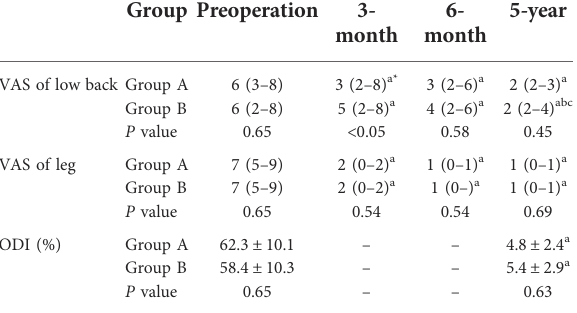
TABLE 3 VAS of low back, leg and ODI in two groups.